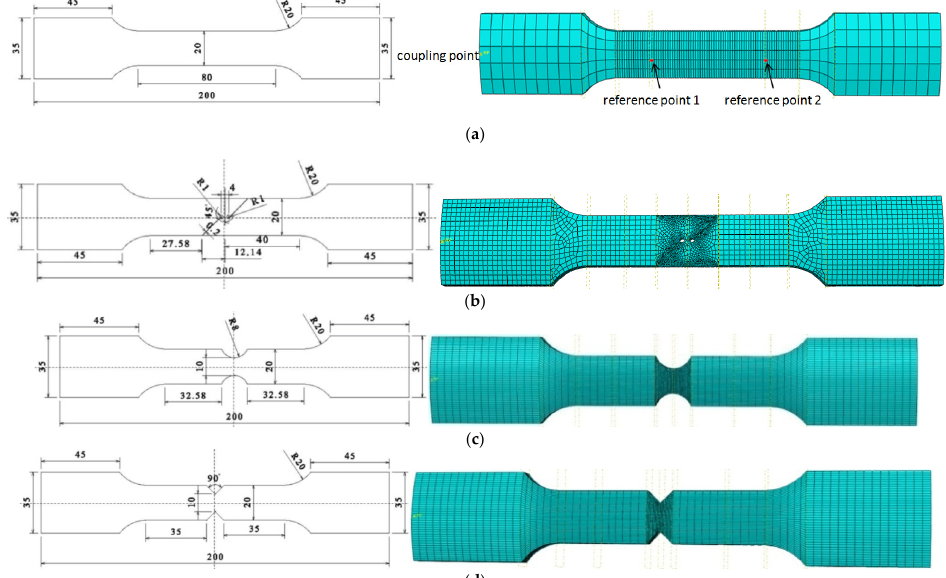
Figure 2. Finite element model of 6061 aluminum alloy tensile samples. ( a ) Circular arc tensile sample. ( b ) Shear sample. ( c ) Arc-shaped notched tension sample R = 8 mm. ( d ) V-shaped notched tensile sample α = 90°.